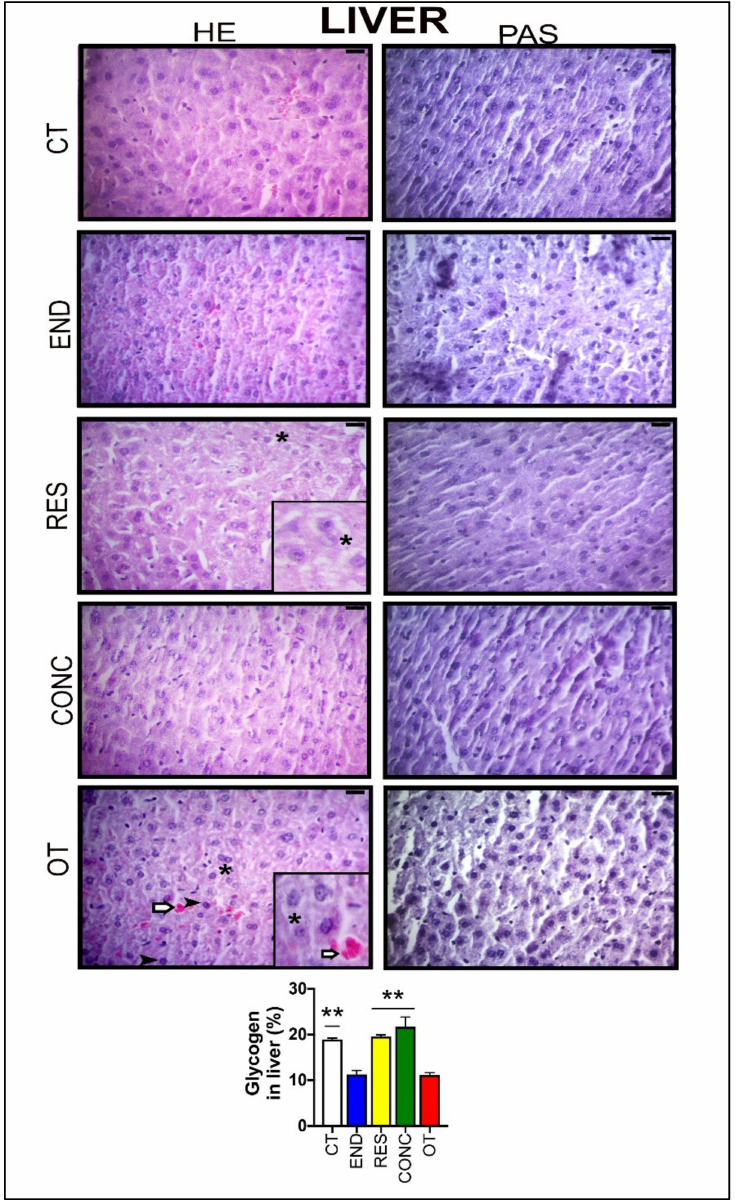
Figure 3. Histological characterization ( × 400) of the liver by hematoxylin-eosin (HE) and periodic acid Schi ff (PAS) and, glycogen contents in the liver. Bar = 20 µ m. Data correspond to the mean ± SEM of 4–5 mice / group. Highlight 1.5 × zoom. Cytoplasmic vacuoles (*). Hyperemia ( ). Nuclei with